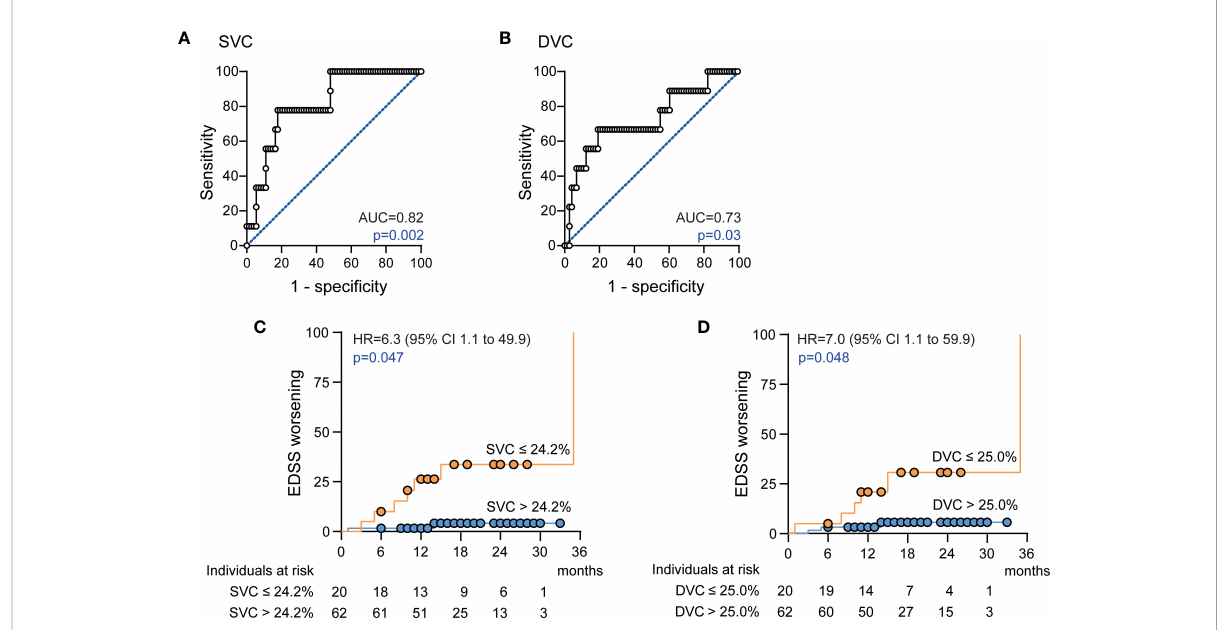
FIGURE 2 Association of the retinal vasculature and disability worsening (A) Receiver operating characteristics (ROC), ROC curve and area under the curve (AUC) measures for super fi cial vascular complex (SVC) vessel densities; (B) ROC curve and AUC measures for deep vascular complex (DVC) vessel densities; (C) Cumulative fraction of patients with con fi rmed disability worsening strati fi ed by SVC vessel densities ≤ 24.2% and > 24.2% at baseline; (D) Cumulative fraction of patients with con fi rmed disability worsening strati fi ed by DVC vessel densities ≤ 25.0% and > 25.0% at baseline; (C, D) : Kaplan-Meier plots with Cox proportional hazards regression adjusted for age, sex, disease duration, disease modifying therapy and thickness of the common ganglion cell and inner plexiform layer. Hazard ratio (HR), con fi dence interval